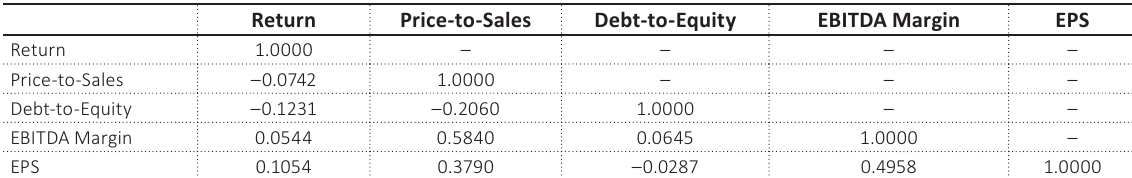
Table 2. Correlation matrix of variables